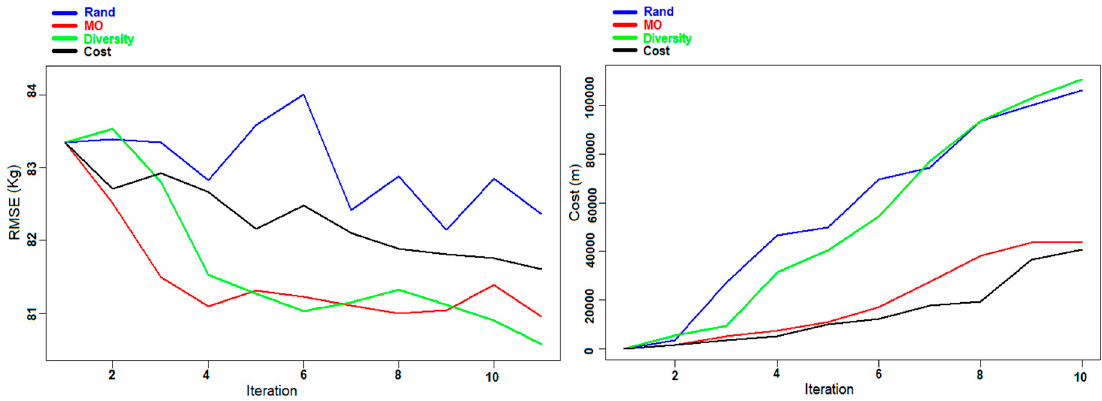
Figure 9. Experiment E: Evolution of the RMSE ( left panel ) and the cost ( right panel ) of AGB prediction for the Hadeland dataset during the different iterations.